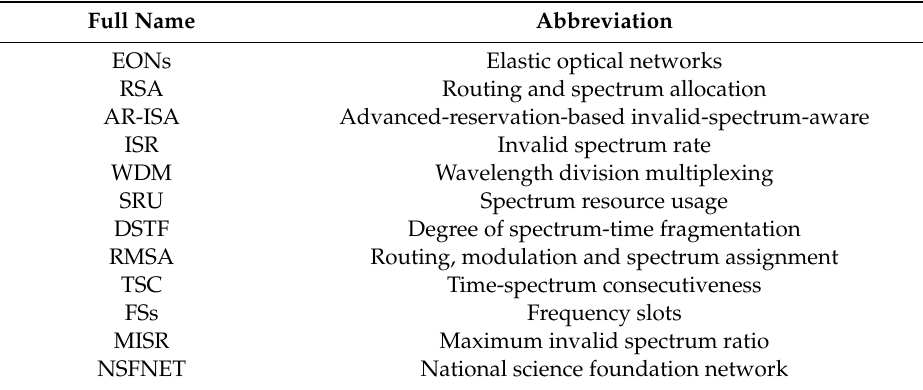
Table 2. A summary of acronyms.